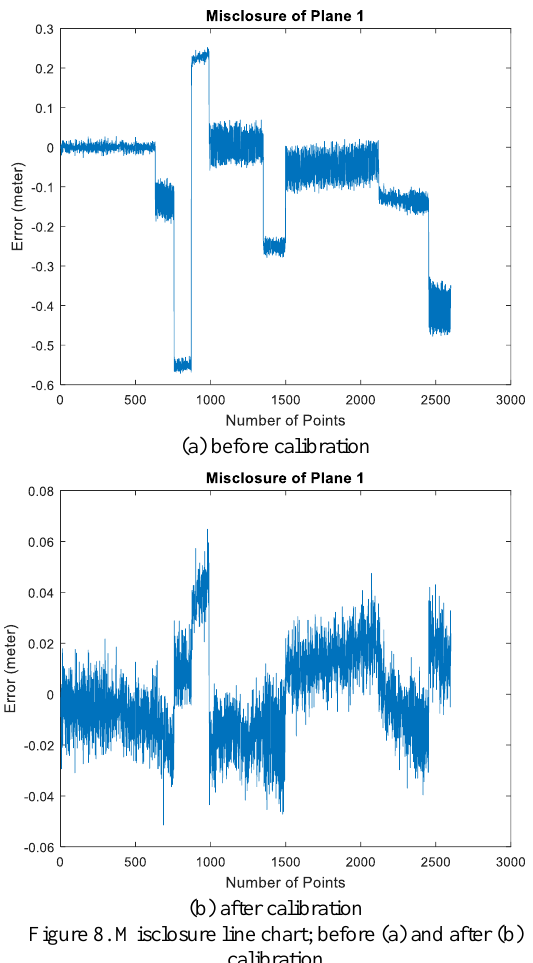
Figure 8. Misclosure line chart; before (a) and after (b) calibration